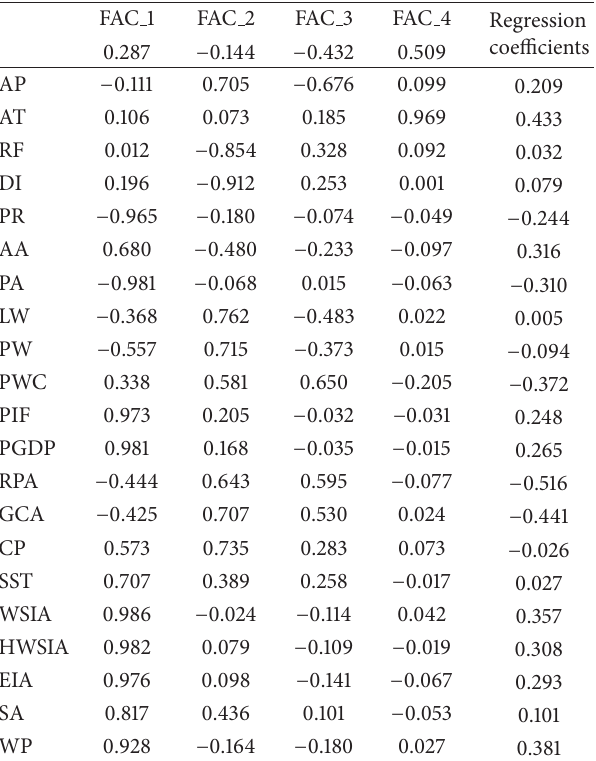
Table 9: Data transformation.